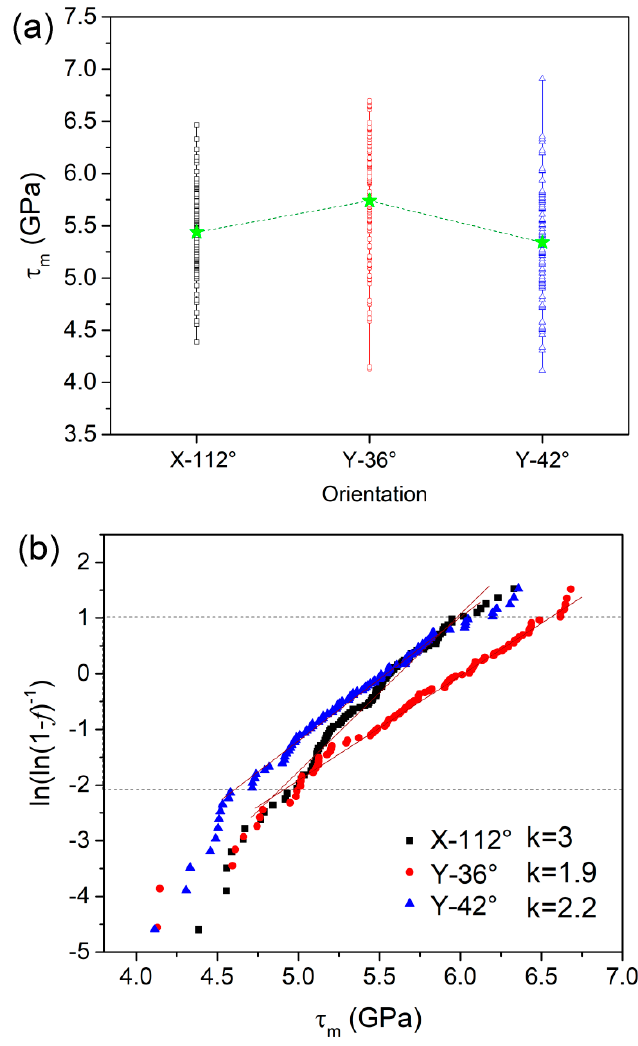
Figure 4. ( a ) The values of τ m on the three orientations, in which mean value of each plane was depicted; ( b ) the correlation between ln[ln(1- f ) − 1 ] and maximum shear stress τ m for the three planes. Linear fitting was employed to estimate the activation